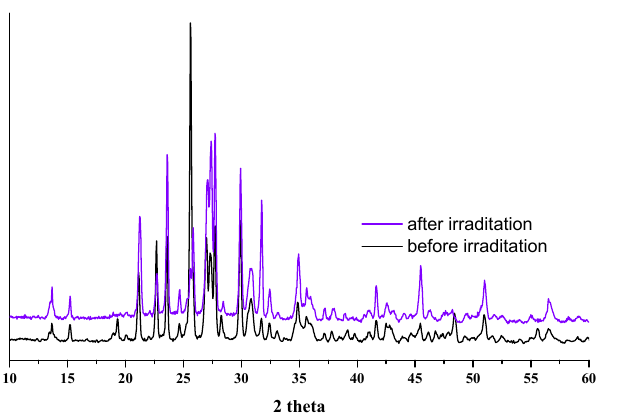
Figure 6. X-ray diffraction patterns of the ceramics based on bentonite clay, including after irradiation up to 10 9 Gy.